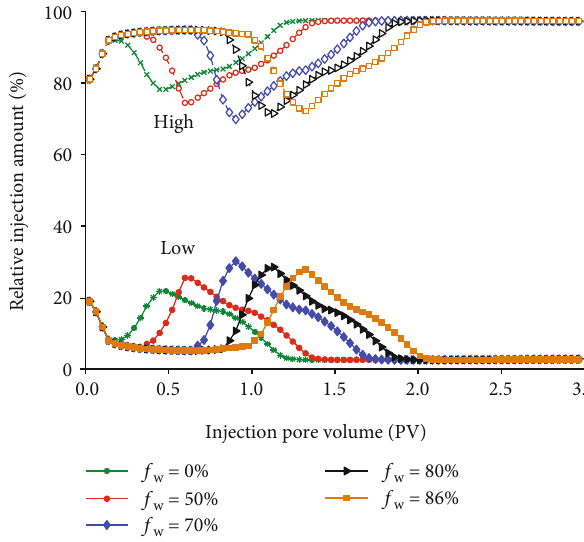
Figure 11: Injection conformance behavior for reservoirs with di ff erent polymer fl ooding timing.